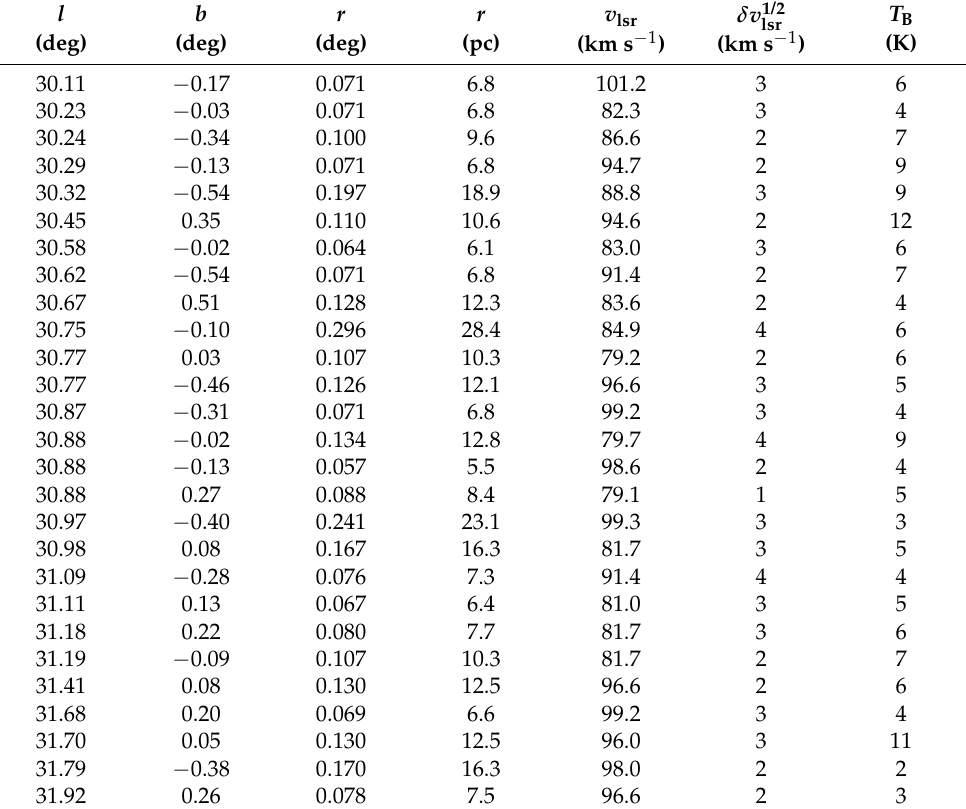
Figure A3. Open circles with thin bars indicate positions of CO bubbles traced in the channel maps between 80 and 100 km s − 1 shown in Figures A1 and A2, and approximate extent by the bar lengths. Thick red circles and bars show positions and extents of extended radio continuum sources at 5.8 GHz from the VLA observations [29]. Table A1. Parameters of CO